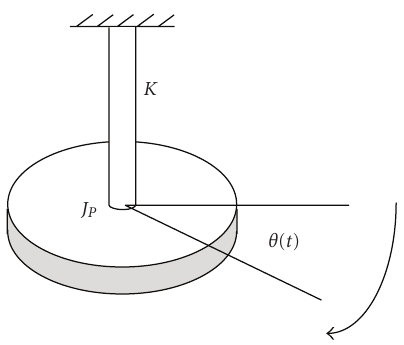
Figure 2: The mechanical model of a torsional dynamic